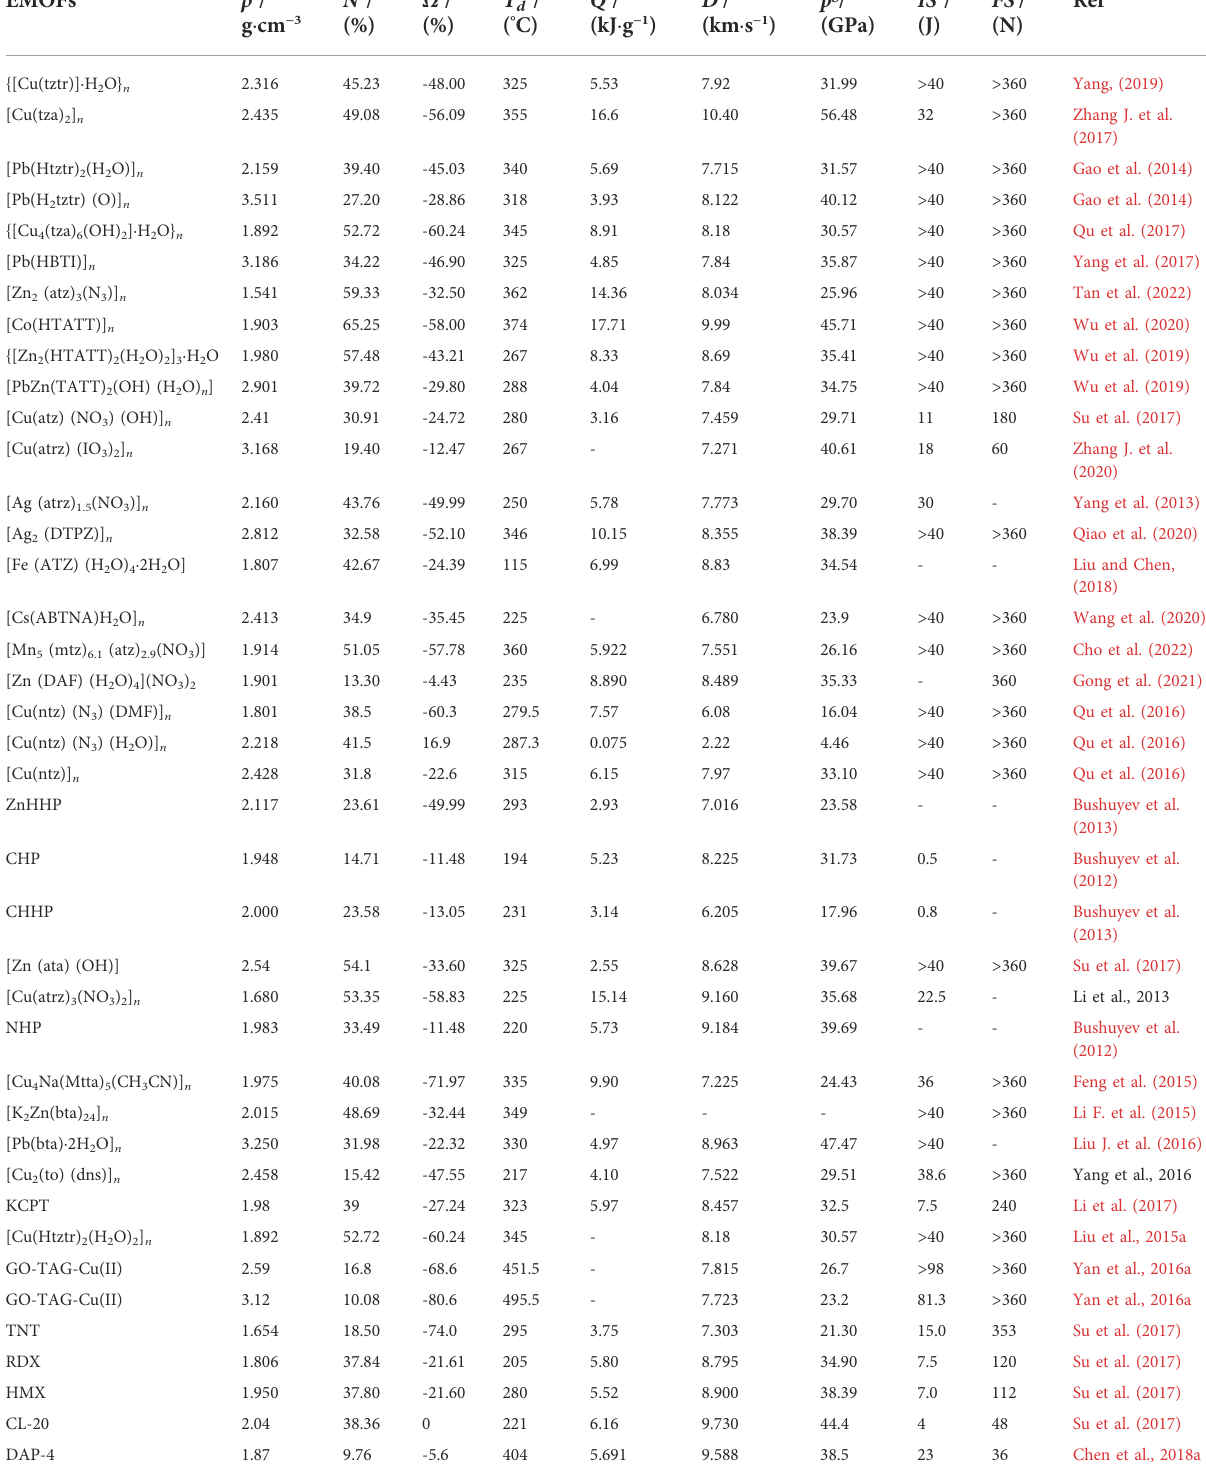
TABLE 3 The physicochemical properties of novel energetic burning rate catalysts and some classical energetic materials. EMOFs ρ a /